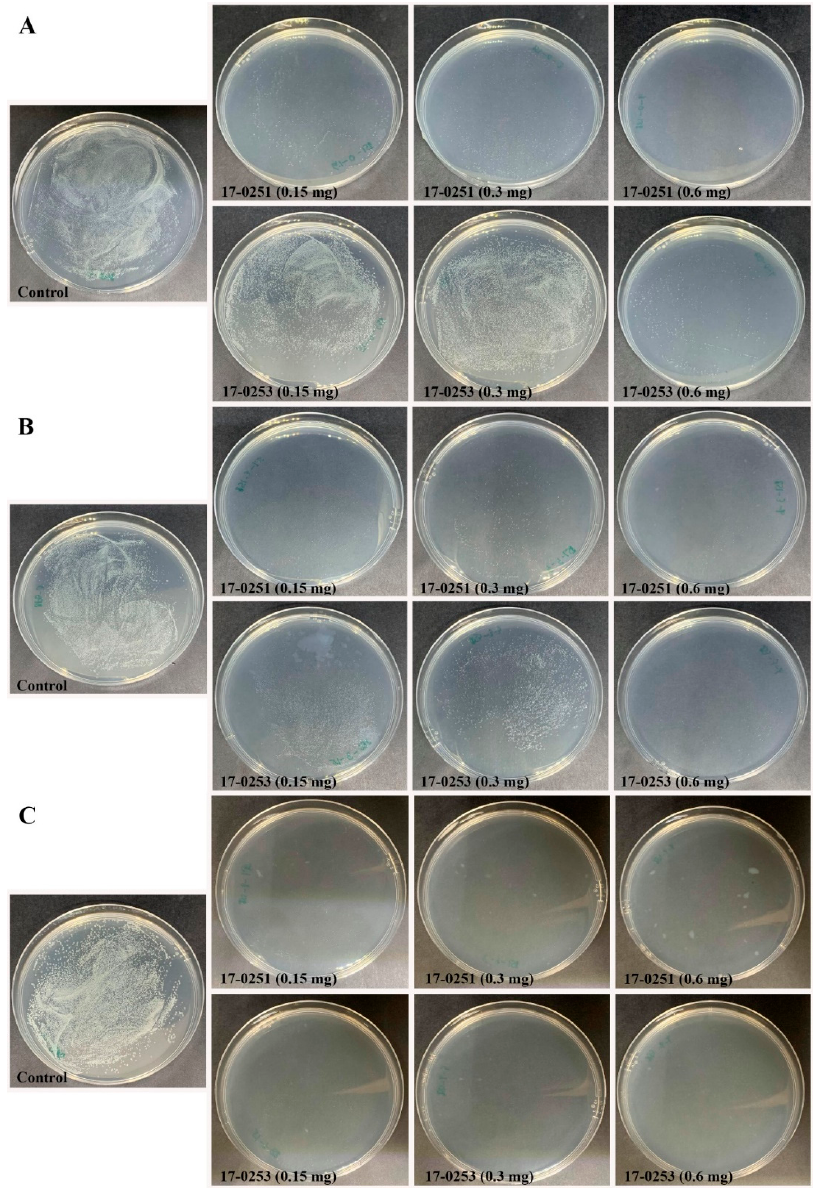
Figure 2. Efficacy of the time kill assay of endophytic fungi crude extract Neocosmospora sp. MFLUCC 17-0251 and MFLUCC 17-0253 in suppression of Aac , JT-0003 after 24 h. Inhibition of Aac growth at ( A ) 0 h, ( B ) 3 h, and ( C ) 6 h. Control refers to bacterial suspension cultured without fungal crude extracts.